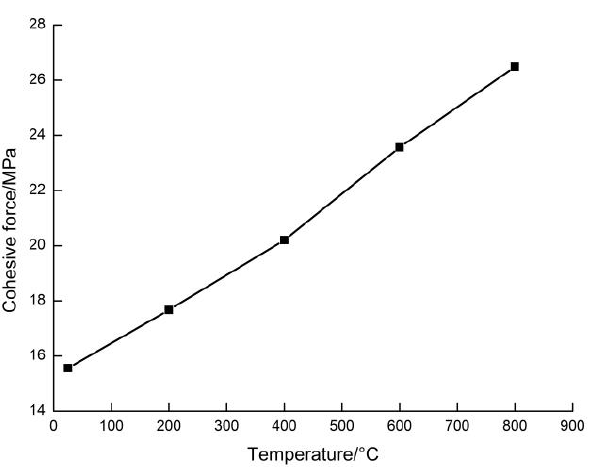
Figure 9. Relationship between sandstone cohesion and temperature.